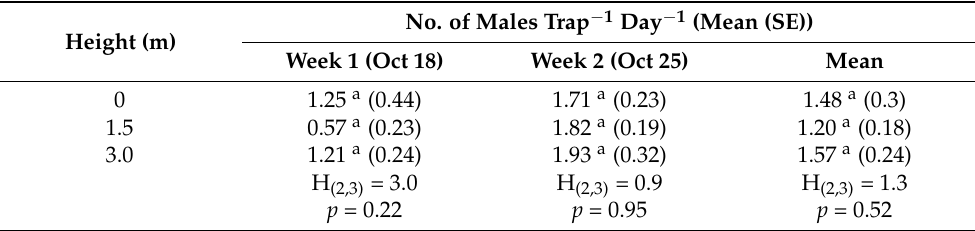
Table 3. Captures of male Chilecomadia valdiviana in traps at different heights in the tree canopy in an apple orchard during 2016 in the Maule Region, Chile.